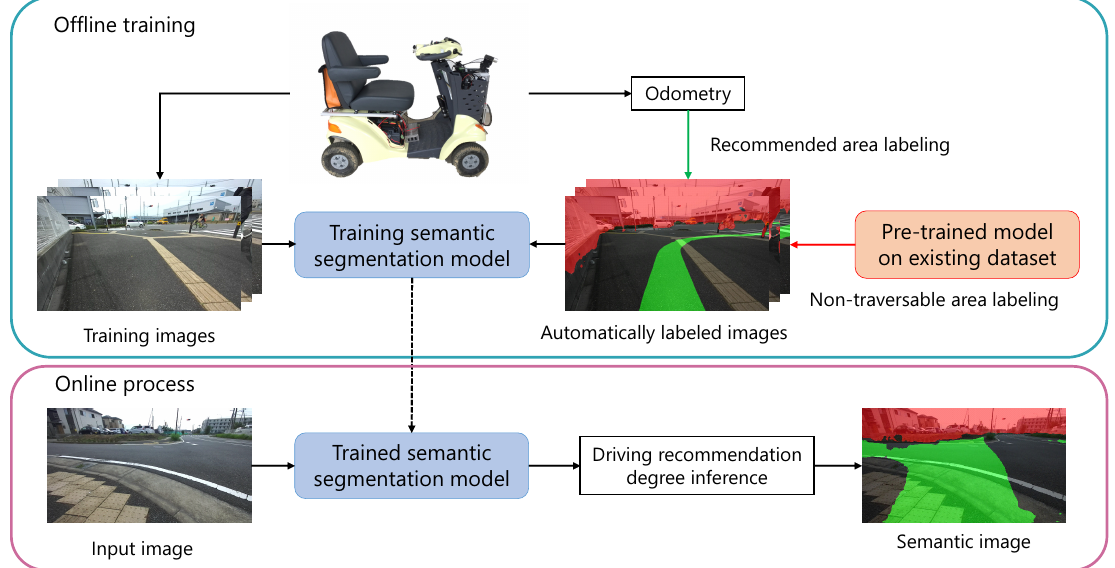
Figure 3. Pipeline of driving recommendation degree inference via offline training using automatically labeled images and online semantic